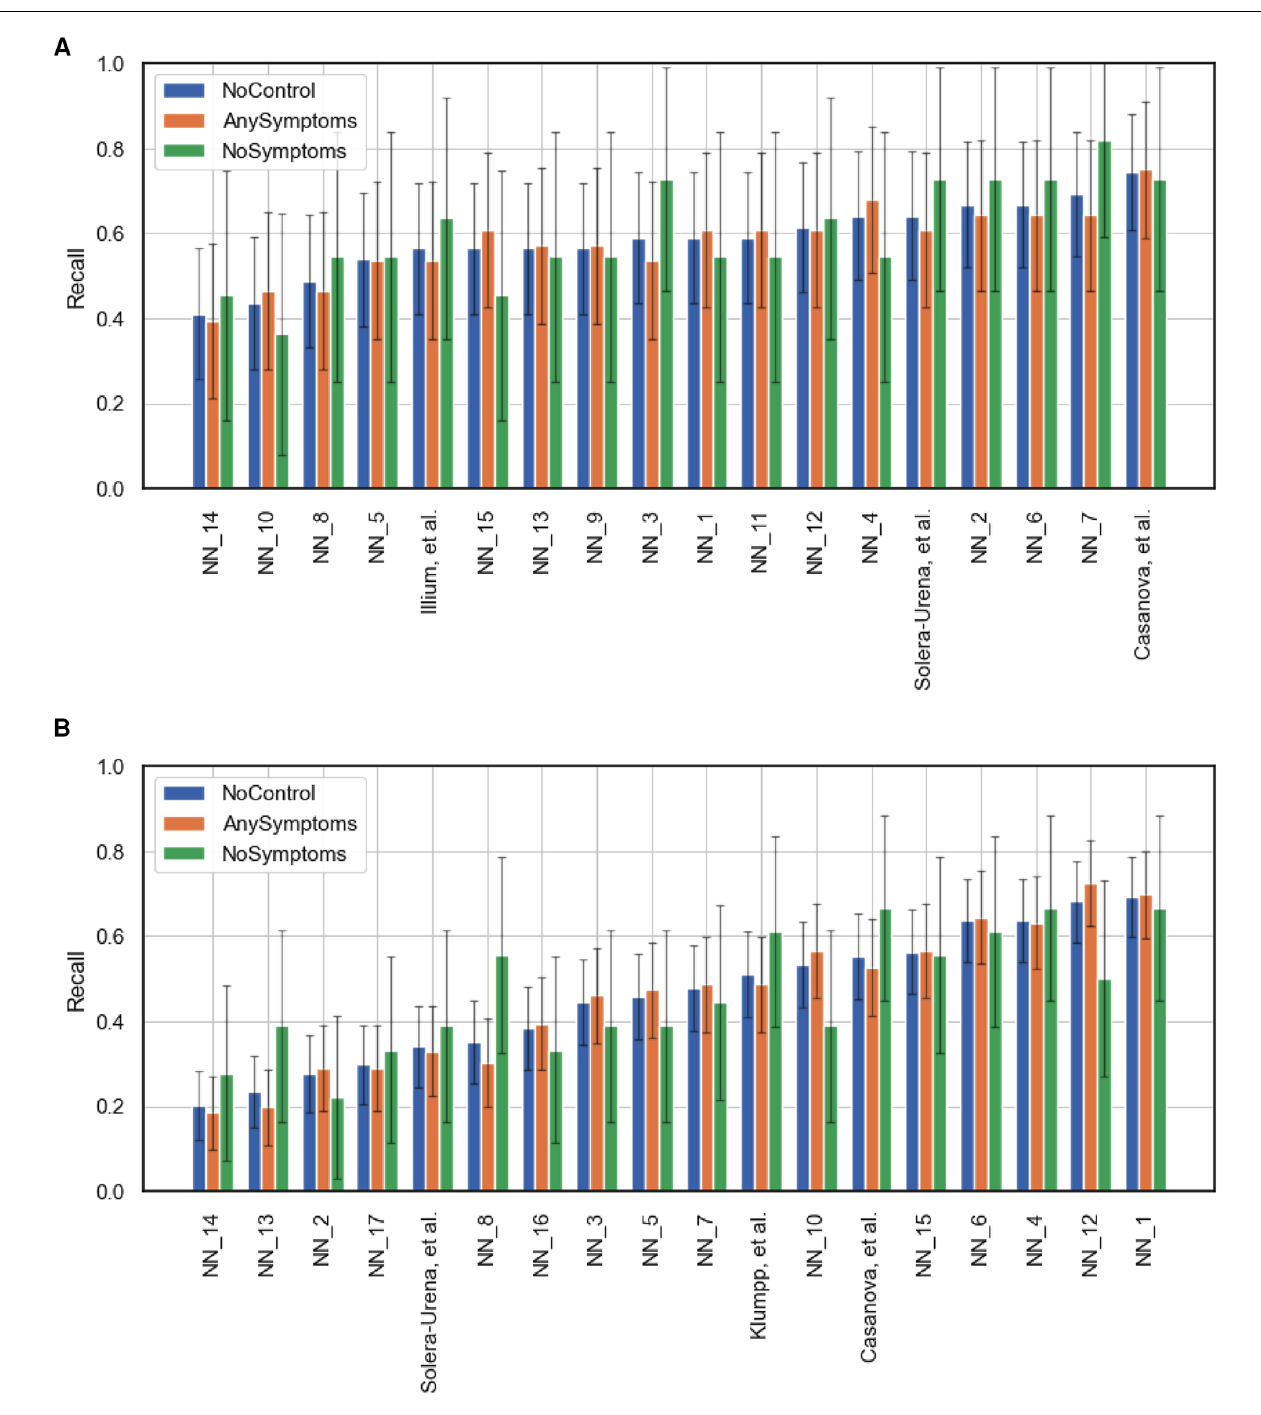
FIGURE A1 Team performance on the full test set (NoControl) and two curated test sets featuring only test instances where the participants either had at least one symptom (AnySymptoms) or were displaying no symptoms at all (NoSymptoms). The metric reported is recall for positive cases. 95% con fi dence intervals are shown, calculated via the normal approximation method. ( A ) Corresponds to the COVID-19 Cough Sub-Challenge, CCS, and ( B ) the COVID-19 Speech Sub-Challenge,